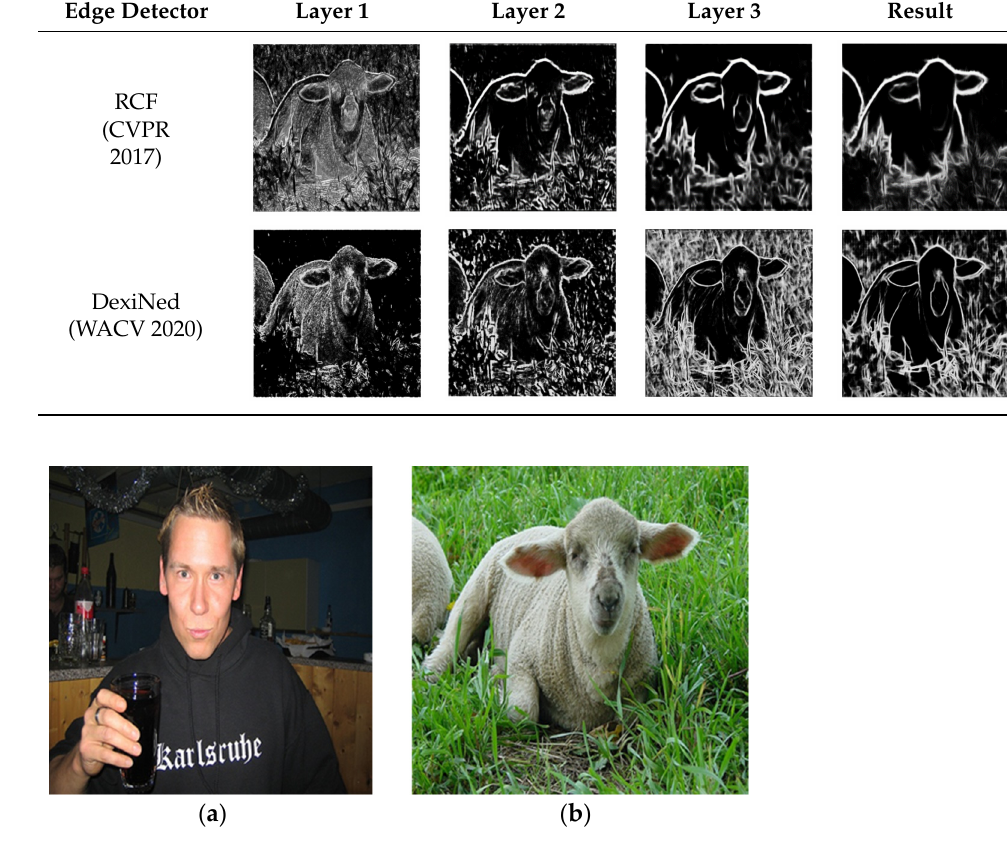
Figure 2. Example of color images: ( a ) person ( b )